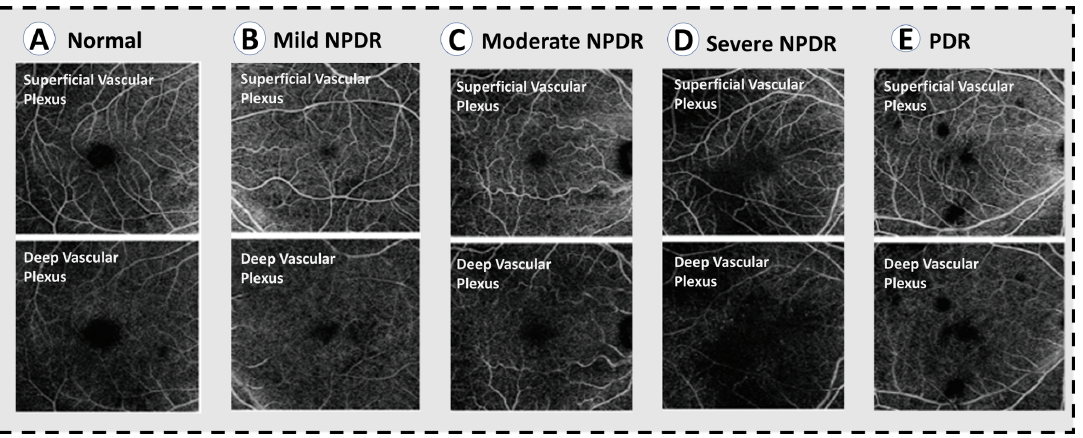
Figure 4. OCT angiograms across varying severities of diabetic retinopathy. ( A ) Normal OCTA. ( B ) Mild NPDR, showing mild loss of vessel density. ( C ) Moderate NPDR with lower vessel caliber and further loss of vessel density. ( D ) Severe NPDR, showing significant areas of capillary non- perfusion in the superifical and deep plexuses, as well as microaneurysms. ( E ) PDR, showing similar vascular changes to severe